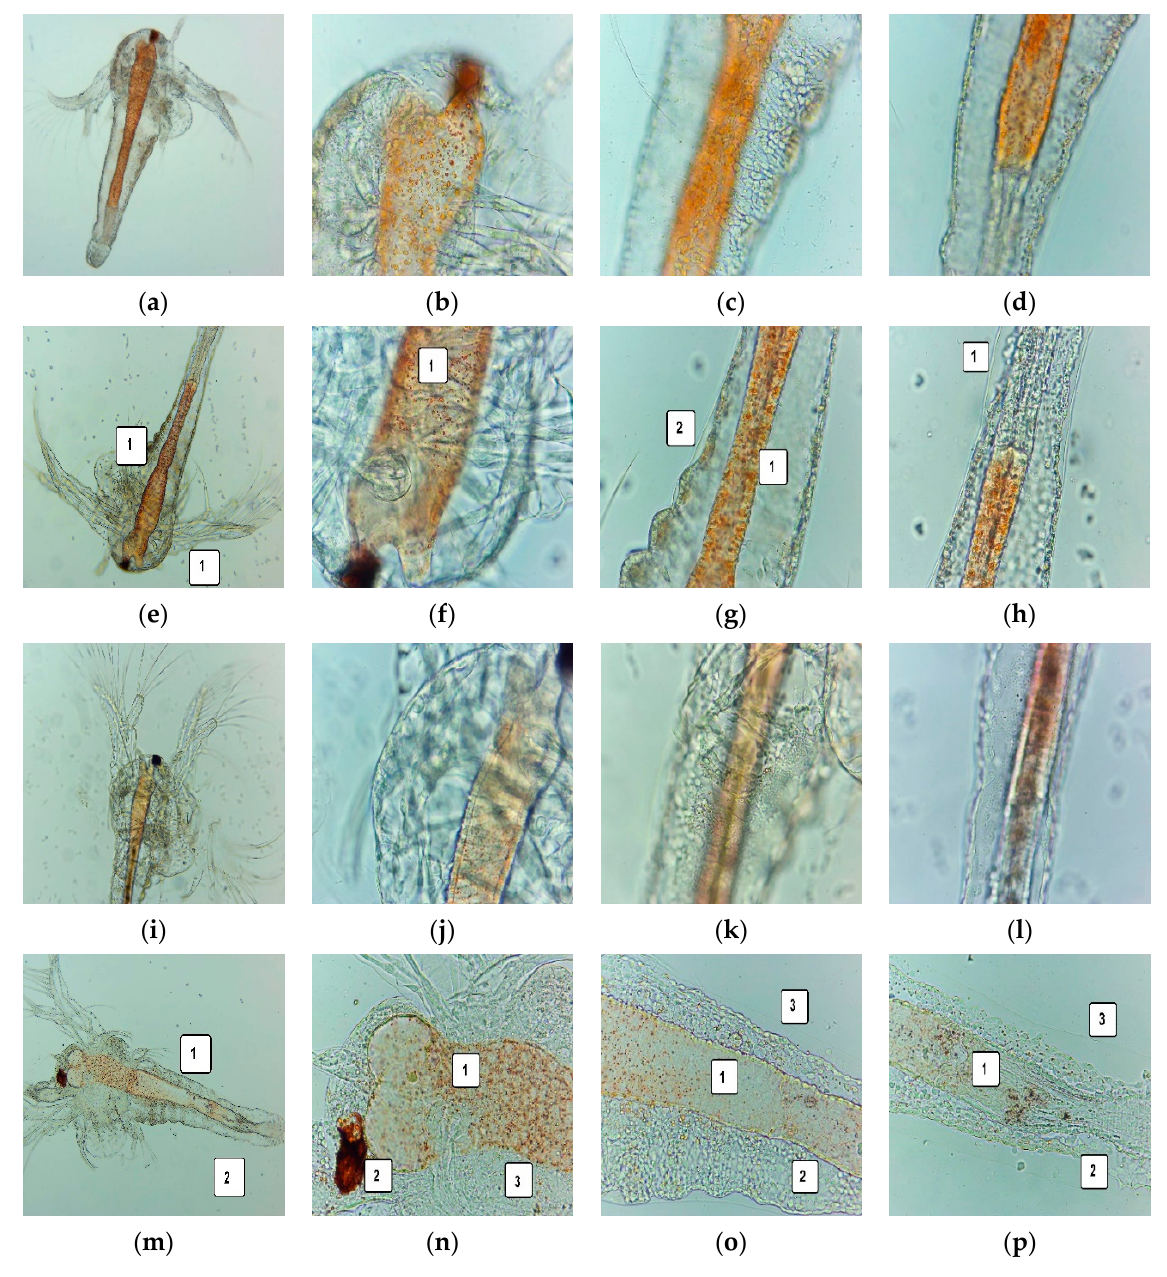
Figure 7. A. salina larvae after 24 and 48 h exposure to F-UBE-HPC—microscopic images at 100× ( a , e , i , m ) and 400× ( b – d , f – h , j – l , n – p ). After 24 h: blank ( a – d ) and sample ( e – h ); after 48 h: blank ( i – l ) and sample ( m – p ). ( e ) contraction of the digestive tube in the upper and middle portion (1); ( f ) reduced amount of food in the upper digestive tube (1); ( g ) early digestive blockage (1), low detachment of the cuticle from larval tissue (2); ( h ) low detachment of cuticle from the peripheral larval tissues (1); ( m ) dead larvae with massive digestive blockage (1) and tissue destruction (2); ( n ) digestive blockage (1) and massive tissue damage (2,3); ( o , p ) low quantity of foods in the digestive tube (1), massive tissue destruction (2) and high detachment of the cuticle from larval tissues (3); F-UBE-HPC—bioadhesive oral film loaded with U. barbata dry ethanol extract.